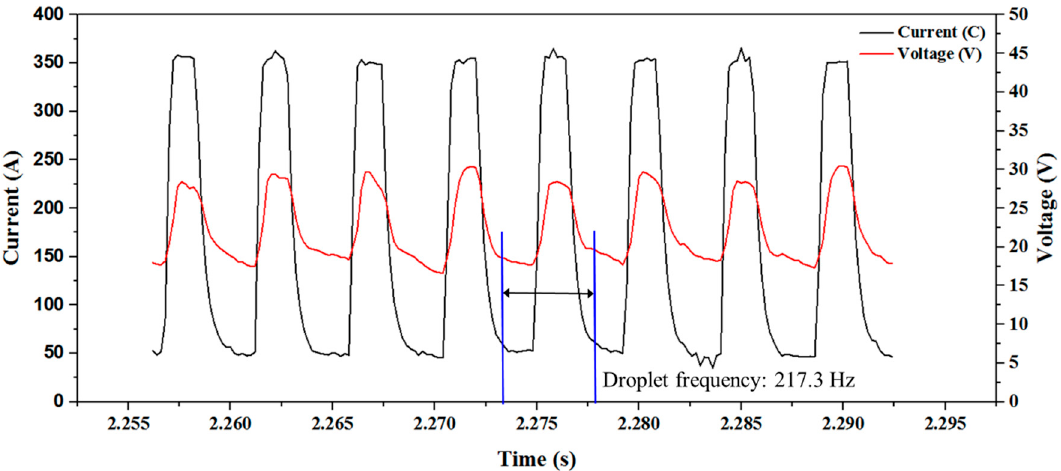
Figure 6. Welding signals with a WFR of 9 m / min.